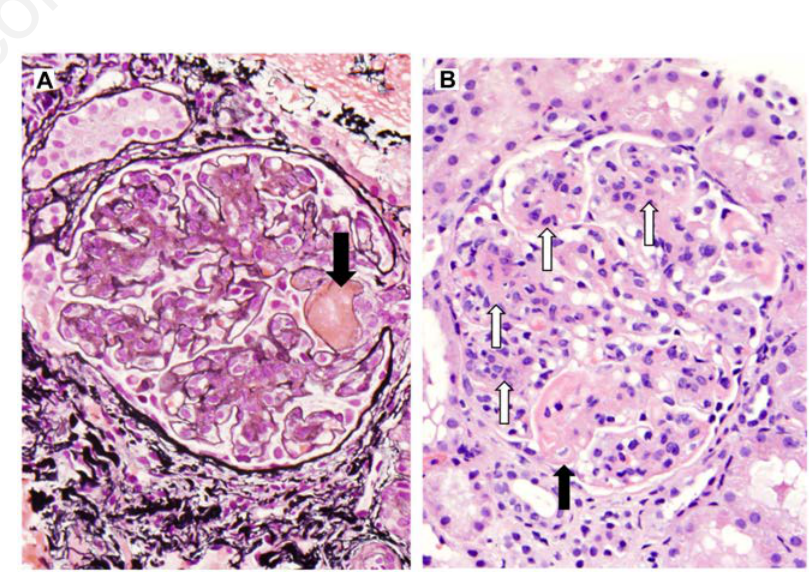
Figure 1. Renal biopsy images demonstrating the presence of Class IV G (active) lupus nephritis. A) Jones Silver stain demonstrating fibrin thrombus (arrow) within a hilar